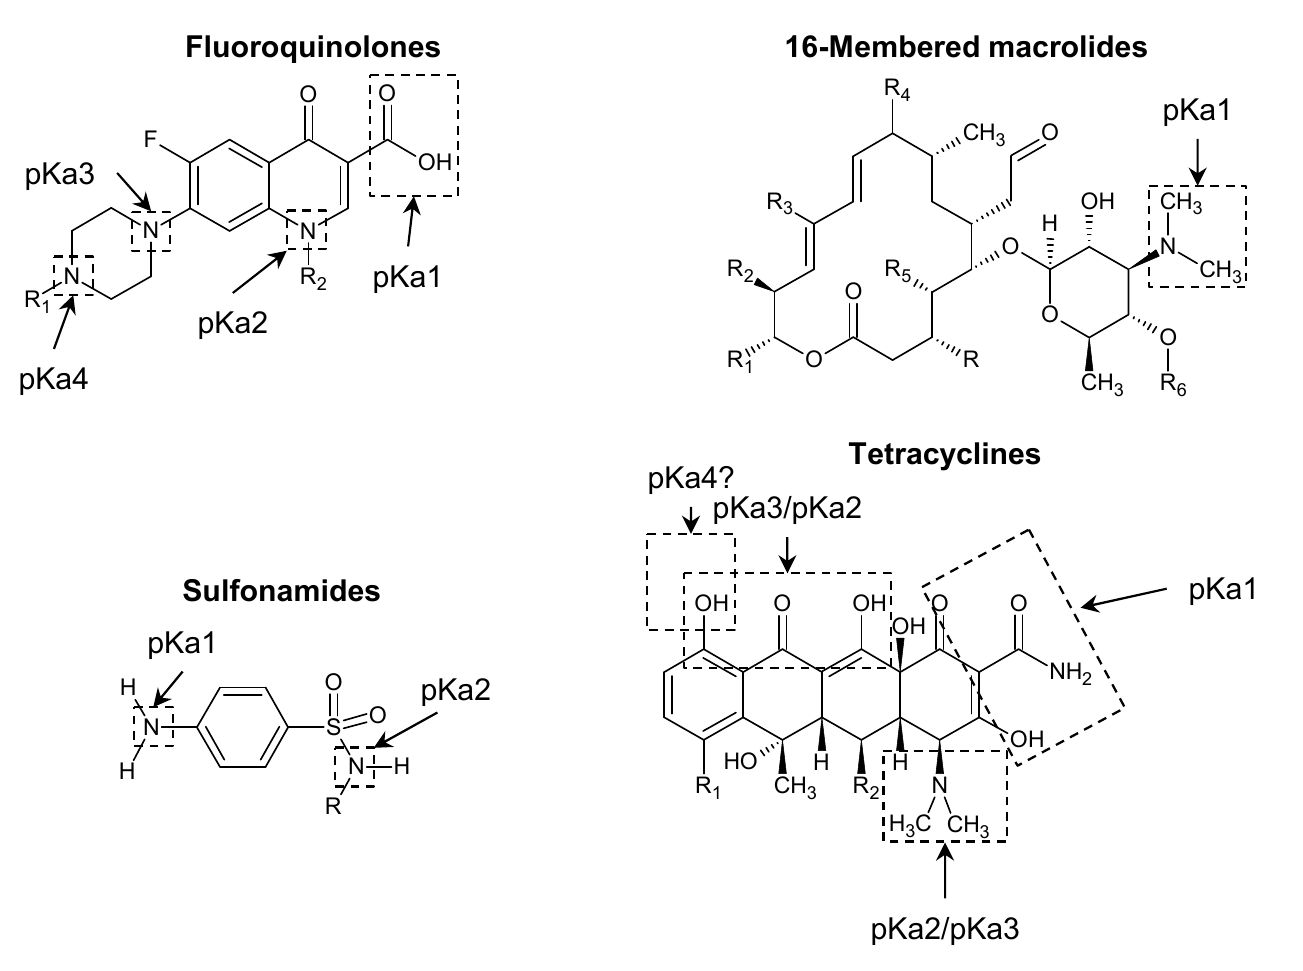
Figure 2. Specific moieties corresponding to the pKa values of the generic structures of the selected classes of antibiotics considered in this review.